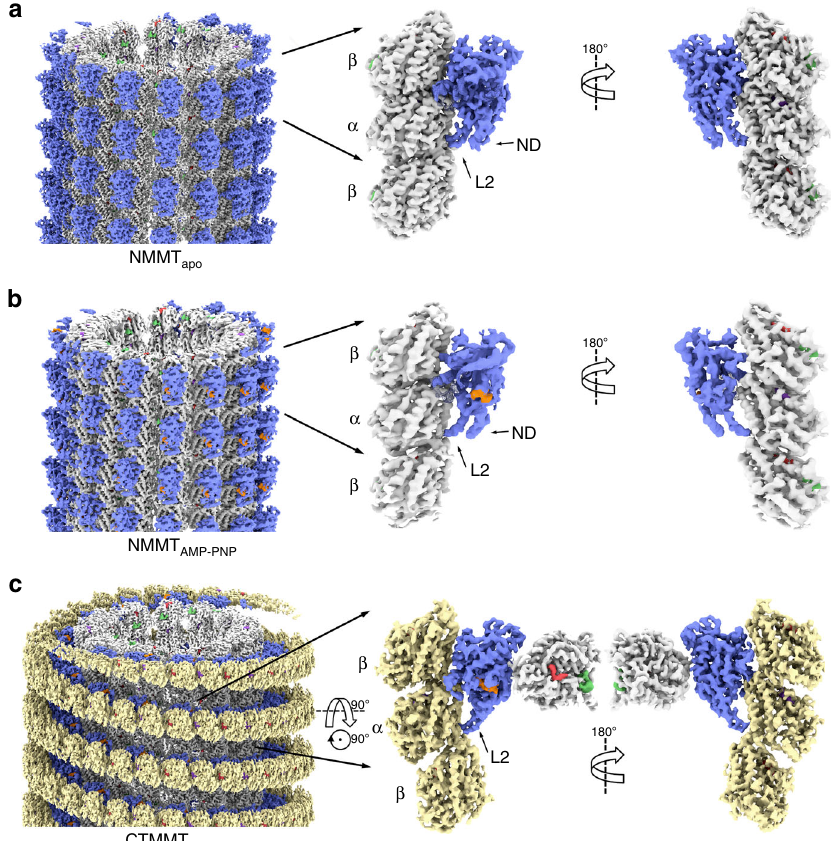
Fig. 1 Cryo-EM 3D density maps. a NMMT apo complex. b NMMT AMP-PNP complex. c CTMMT AMP-PNP complex. Left shows the whole helical 3D map, center and right shows two orientations of one asymmetric unit with an extra β -tubulin subunit. Coloring was done based on the fi tted atomic models: microtubule lattice tubulin (straight tubulin) in white-gray, wrapping tubulin proto fi lament (curved tubulin) in ochre, KLP10A in blue, AMP-PNP in orange, GTP in purple. GDP in red, and paclitaxel in green. Note, that the interaction of the KLP10A motor-domain with straight tubulin in the NMMT complexes ( a , b ) and with curved tubulin in the CTMMT AMP-PNP complex ( c ) are through the same putative kinesin – tubulin interface. An additional kinesin-13-speci fi c tubulin binding site 11,19 mediates the interaction of the motor domain with the microtubule in the CTMMT AMP-PNP